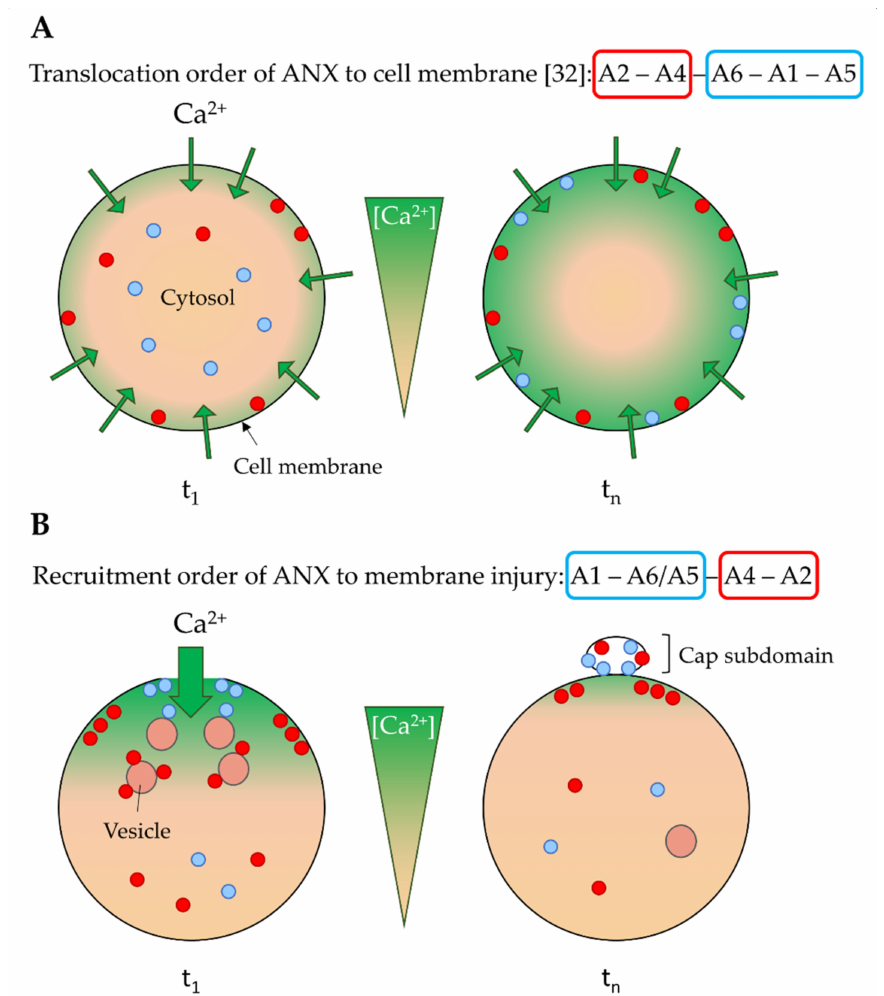
Figure 5. Model of cell membrane translocation and recruitment to the site of membrane injury of ANX according to their Ca 2+ sensitivity. ( A ) As observed in Skrahina et al. [32], treatment with ionomycin, a Ca 2+ ionophore, induces a gradual influx of Ca 2+ in the whole cell (green arrows). At t 1 , first ANX to be translocated to the plasma membrane are therefore the most Ca 2+ sensitive, such as ANXA2 and ANXA4 (red circles). At tn, high increase in the intracellular Ca 2+ concentration causes the sequential translocation of ANX less sensitive to Ca 2+ (blue circles). The order of translocation is as follows: ANXA2, ANXA4, ANXA6, ANXA1, and ANXA5. Data from [32]. ( B ) According to the current study, we propose that a local rupture in the plasma membrane causes a massive entry of Ca 2+ , creating a large gradient. At t1, the high Ca 2+ concentration close to the disruption site induces the binding to plasma membrane of the lesser Ca 2+ -sensitive ANX, such as ANXA1, ANXA6 and ANXA5 (blue circles). Instead, high Ca 2+ -sensitive ANX, such as ANXA2 and ANXA4 (red circles), interact with membranes distant from the site of rupture. In human skeletal muscle cells, the order of recruitment to the site of membrane injury is the following: ANXA1, ANXA6/A5 [17], ANXA4, and ANXA2. Once membrane has been resealed (t n ), ANX present in the cap subdomain, which is localized outside the cell where the Ca 2+ concentration is high, remain in interaction with membranes. Inside the cell, most ANX, except eventually ANXA2, which is the most Ca 2+ -sensitive, are released from membranes when Ca 2+ homeostasis is